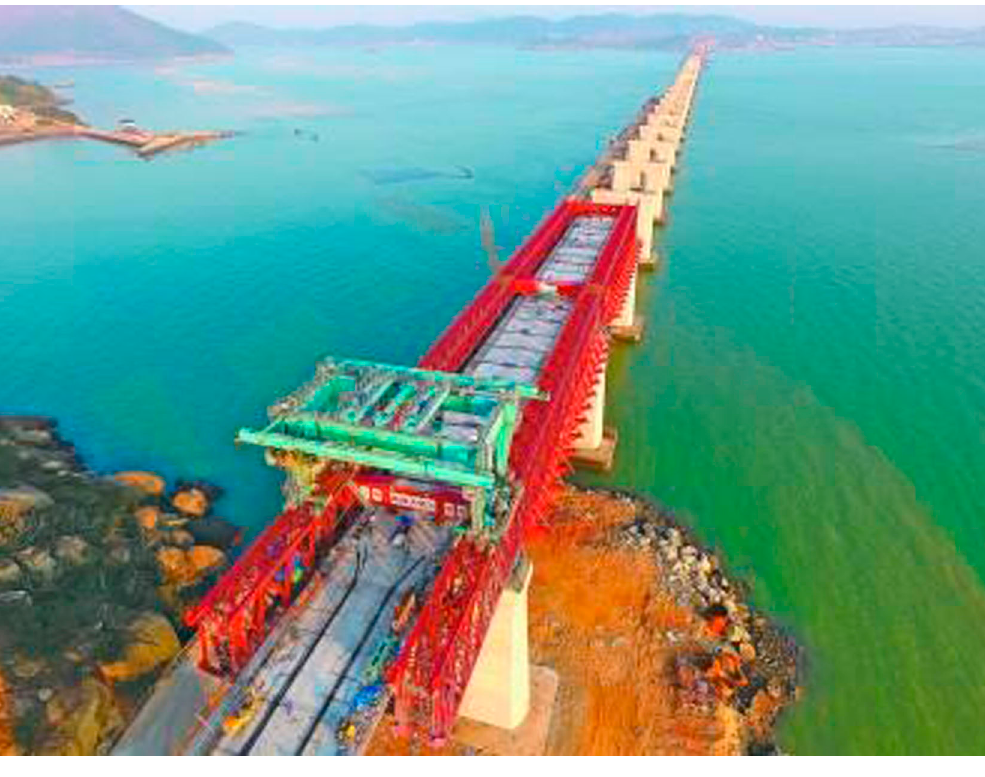
Figure 3. Picture taken for the bridge under construction.